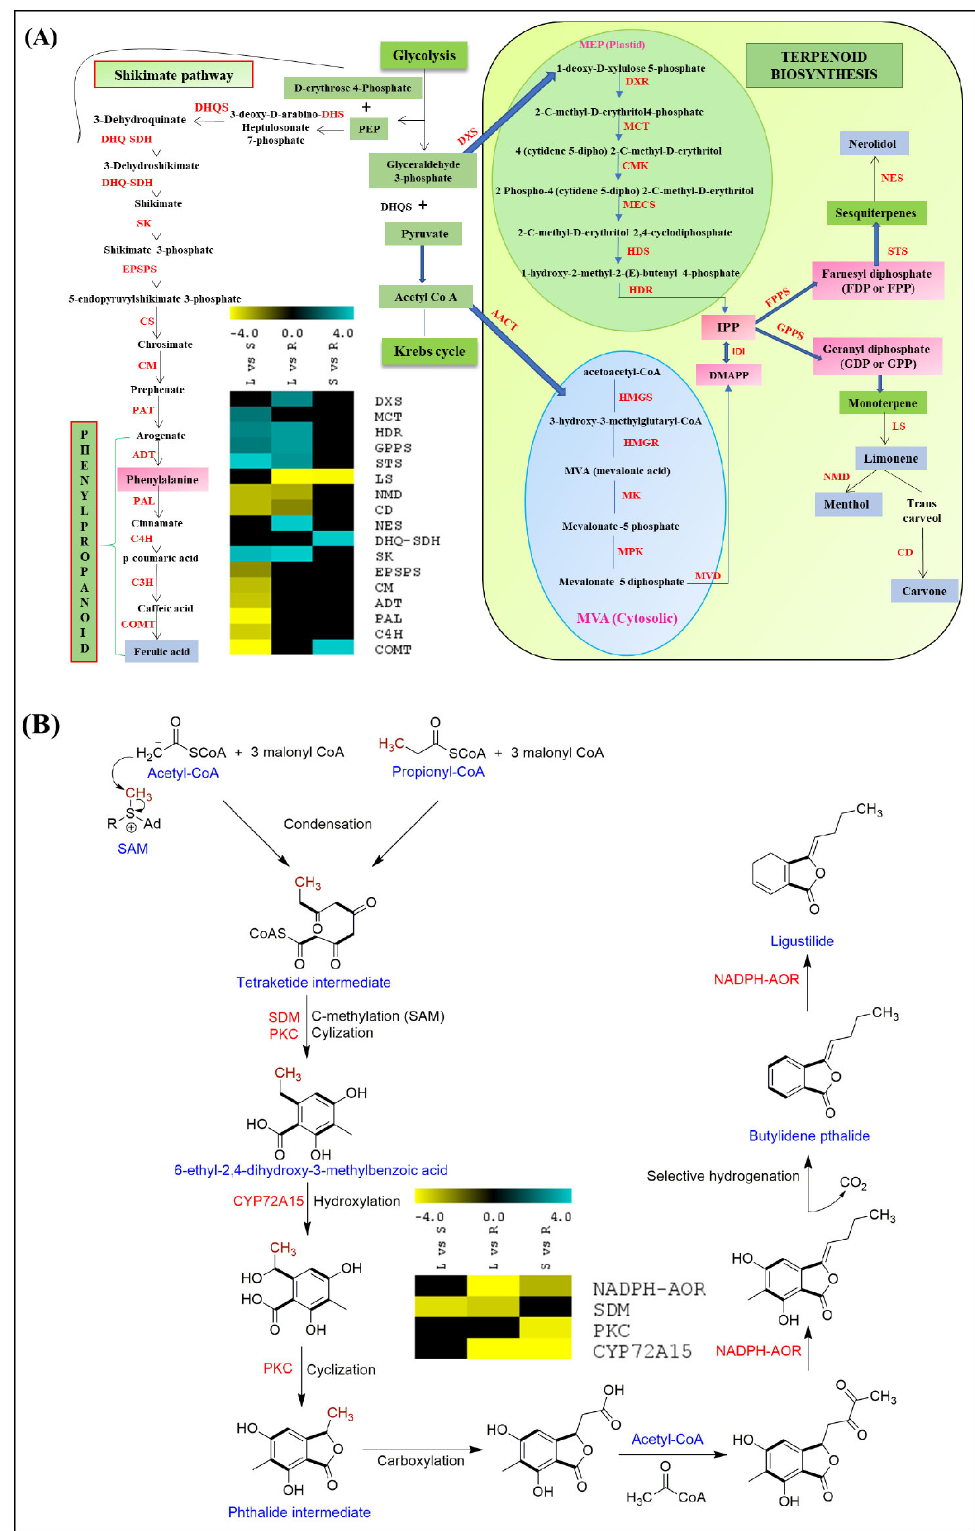
Figure 7. Representations of: ( A ) terpenoid and ferulic acid biosynthesis; ( B ) putative pathway of phthalide biosynthesis in A. glauca . Heatmap representing expression profiles of candidates across three combinations (leaf vs. stem; leaf vs. root; stem vs. root).